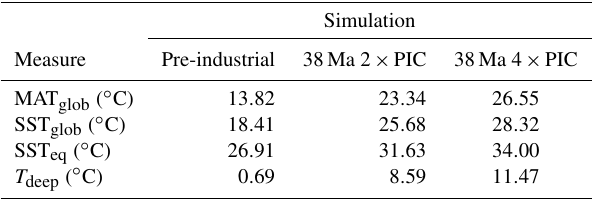
Table 3. Mean equilibrium temperatures over the last 200 model years of each simulation, showing MAT glob : global average air tem- perature (at 2m reference height), SST glob : global average sea sur- face temperature, SST eq : equatorial ( < 23 . 5 ◦ N or S) average SST, and T deep : global average deep-ocean temperature (below